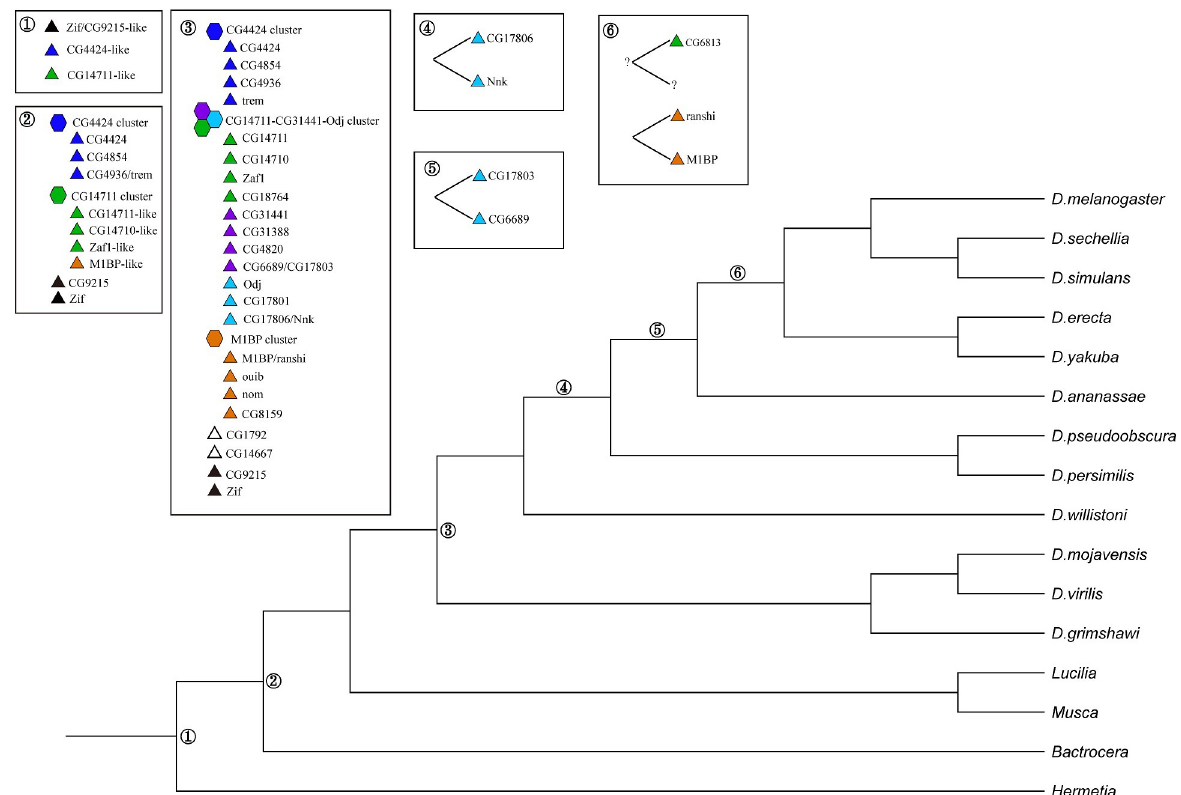
Fig 7. Evolution of the Cucoid clade family in higher flies. Inferred gene duplications in the Cucoid clade based on data in this study and D . melanogaster gene ages reported elsewhere [55]. For details see text. Gene clusters (hexagons) and gene loci (triangles) are indicated. For color code see Fig 2.